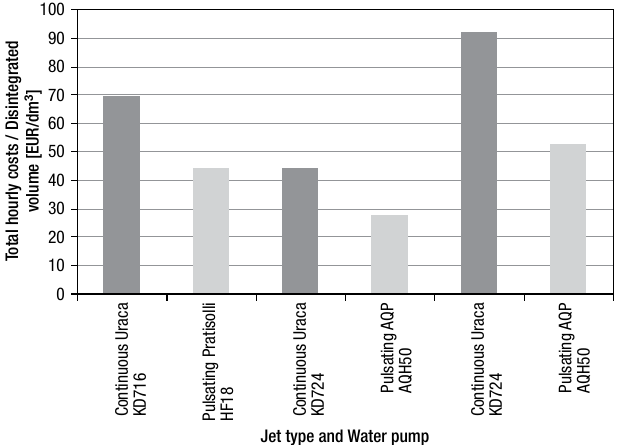
Fig. 4. Total hourly costs for continuous and pulsating water jets per 1 dm 3 disintegrated